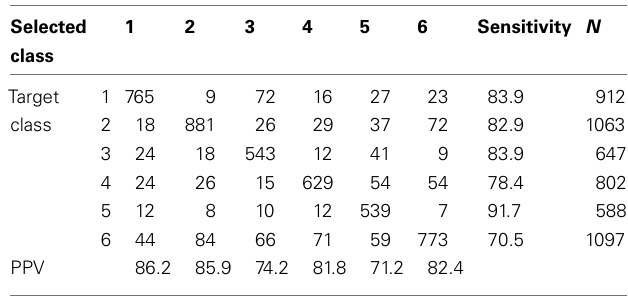
FIGURE 5 | Early stopping performance. For (A) , data is collapsed over all subjects that participated in Session 2.The number of correct and incorrect trials are plotted as a function of the iteration in which a trial was stopped. Accuracy is high in general, and particularly for those trials that were stopped